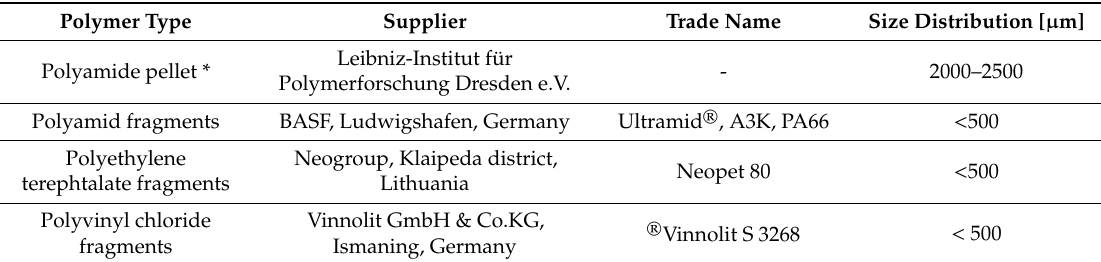
Table 1. Summary of the used polymers. The suppliers, the corresponding trading names, and size in µ m after